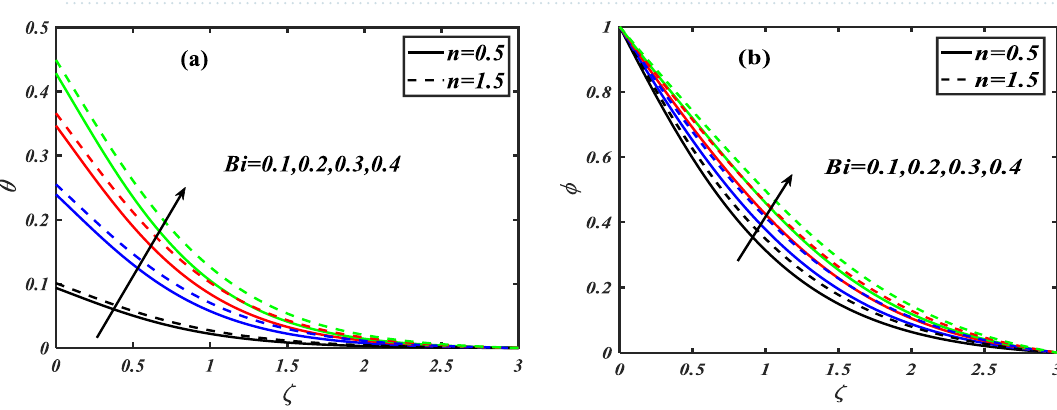
Figure 6. ( a , b ) Illustrates the effect of Biot number on θ(ζ) , φ(ζ)